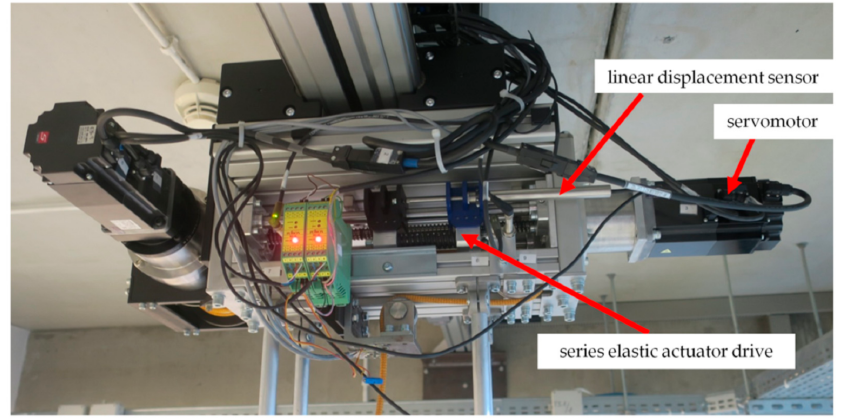
Figure 2. Body weight support